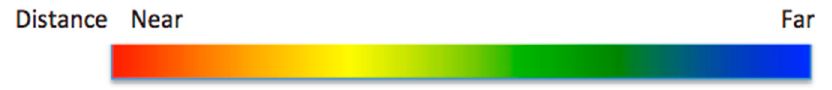
Figure 4. High collision risk area color based on a rainbow color map. The collision area color is white, and it never overlaps with the rainbow